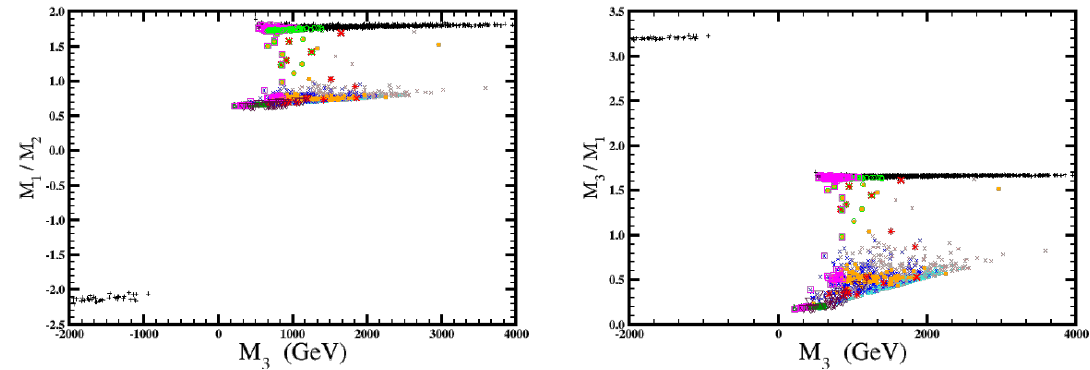
Figure 3 . Values of the gaugino mass ratios vs M 3 at the GUT scale and their correlation with the di(cid:11)erent Planck areas as functions of the GUT ratios for the soft terms. We use the same notation as in (cid:12)gure